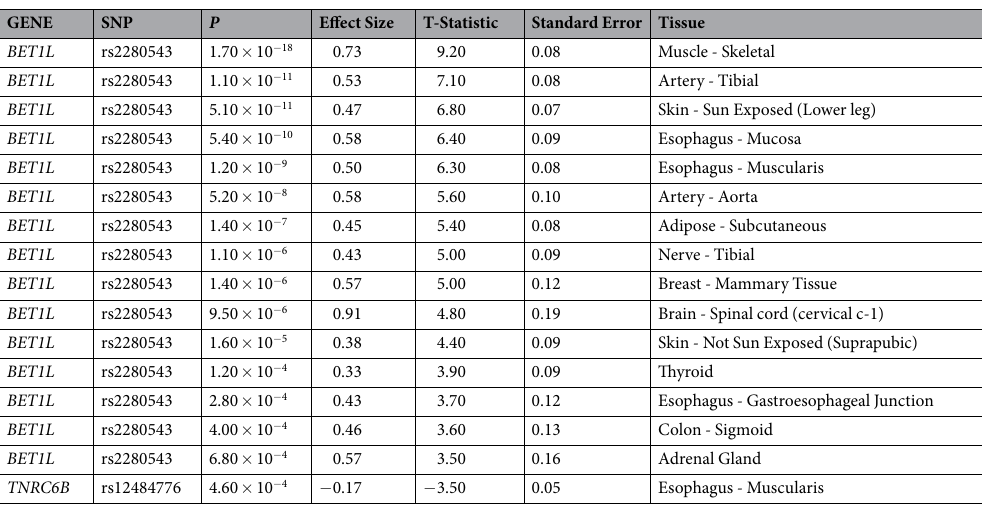
Table 5. Significant eQTL results for rs2280543 and rs12484776. P value threshold after Bonferroni corrections was 0.05/90 ≈ 5 × 10 − 4